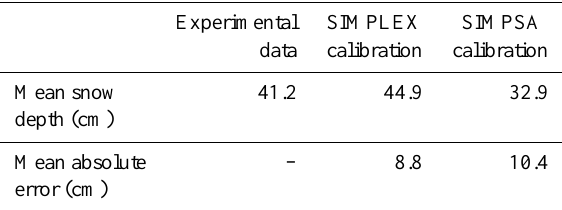
Table 2. Mean snow depth and mean absolute error for the valida- tion